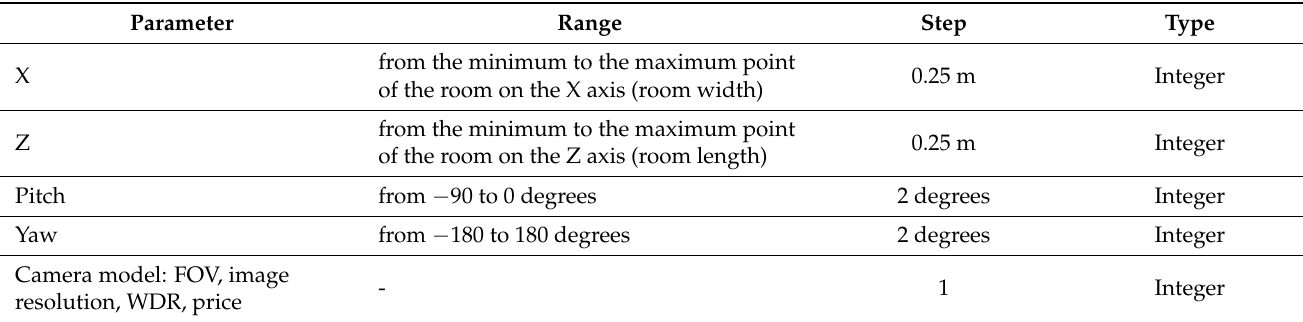
Table 3. Parameters generated by the genetic